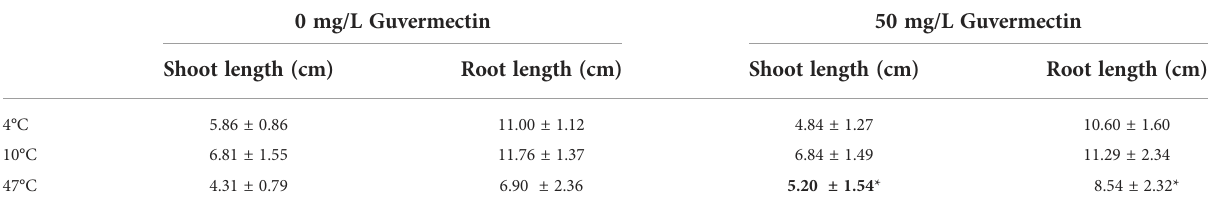
TABLE 4 The effects of guvermectin treatment on the maize seedlings growth in paper roll culture system under different temperatures.